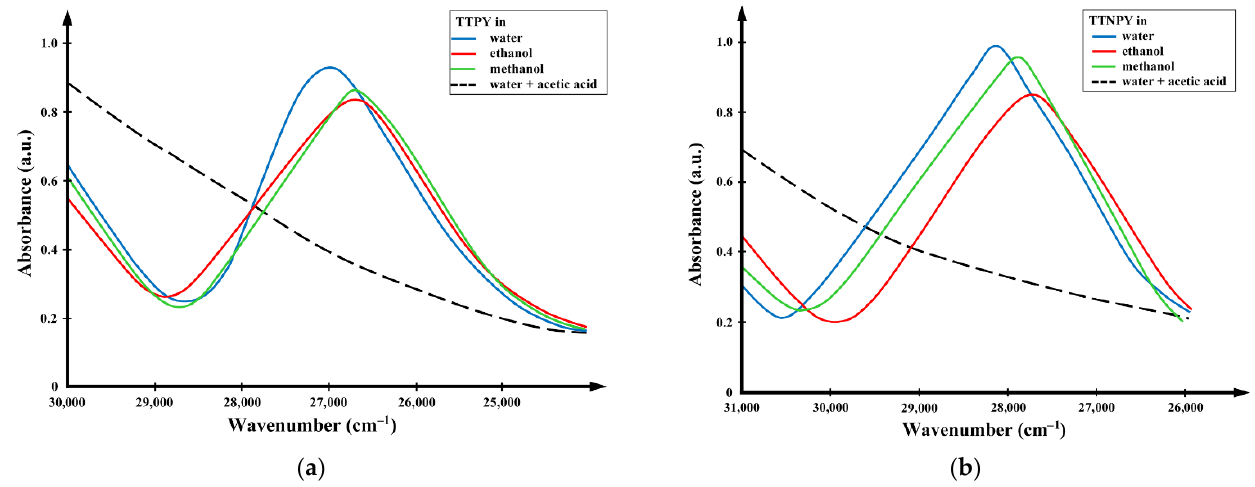
Figure 2. Spectra of 4-tolyl-1,2,4-triazol-1-ium phenacylid (TTPY) ( a ) and 4-tolyl-1,2,4-triazol-1-ium-4 ’ -nitro-phenacylid (TTNPY) ( b ) in water, ethanol, methanol, and water + acetic acid, respectively. Table 1. Molar water composition ( x 1 ), Kamlet – Abboud – Taft parameters ( π *, β , α ) of binary sol-